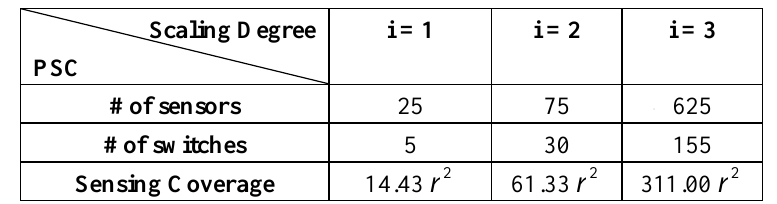
Table 4 . Scalability of